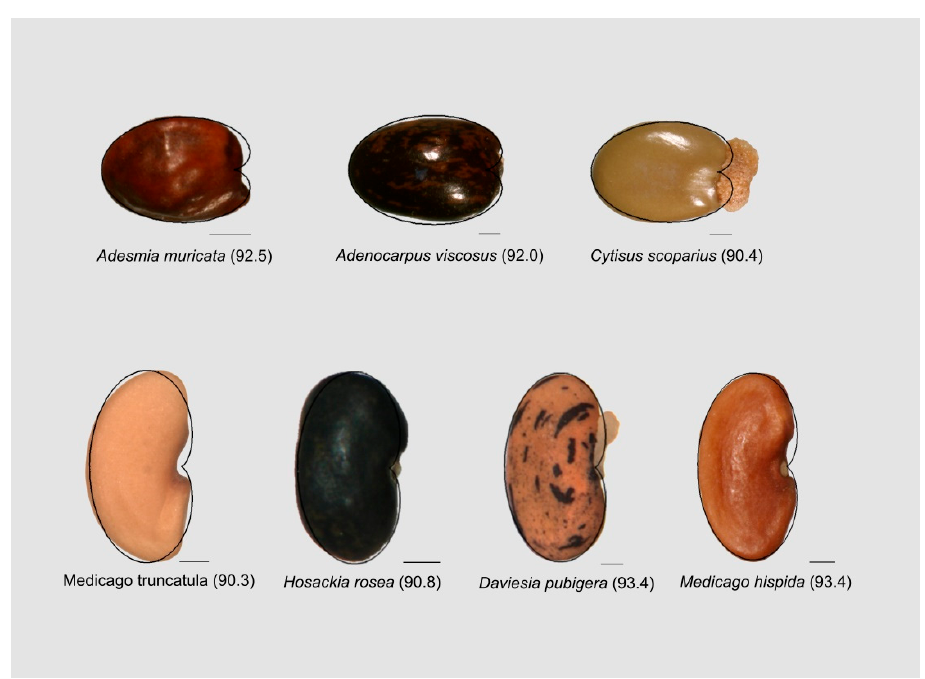
Figure 11. The cardioid elongated by a factor of Phi (The Golden Ratio) either in the horizontal axis (top), or in the vertical axis (bottom) is the figure for seed shape quantification in many species of legumes, including the model species Medicago truncatula . The values indicated correspond to J index in the images shown and do not represent mean values for each particular species. Bar equals 0.5 mm.